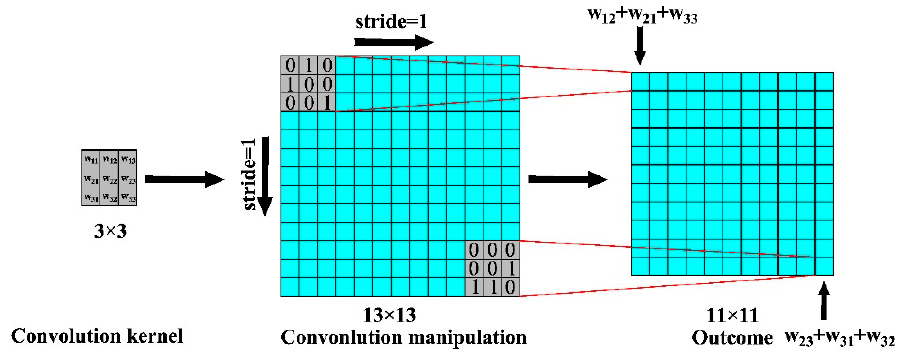
Figure 8. The convolution manipulation (VALID padding).